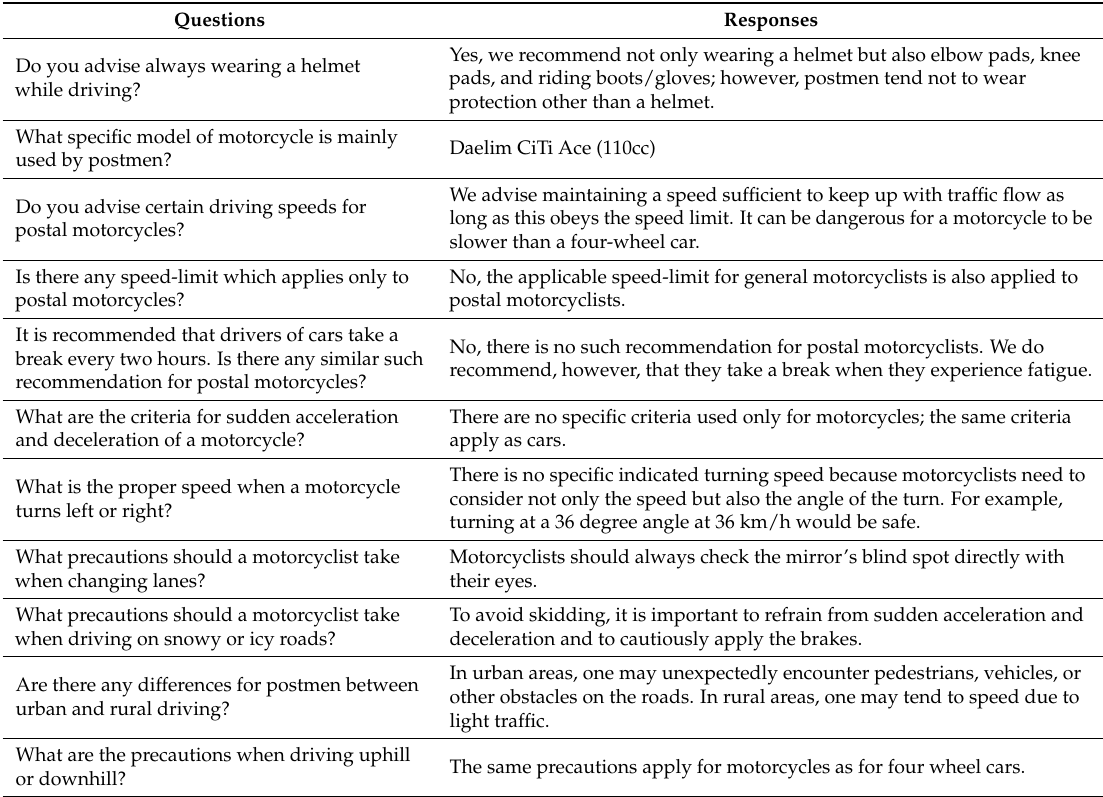
Table 1. Interview with a postal motorcycle